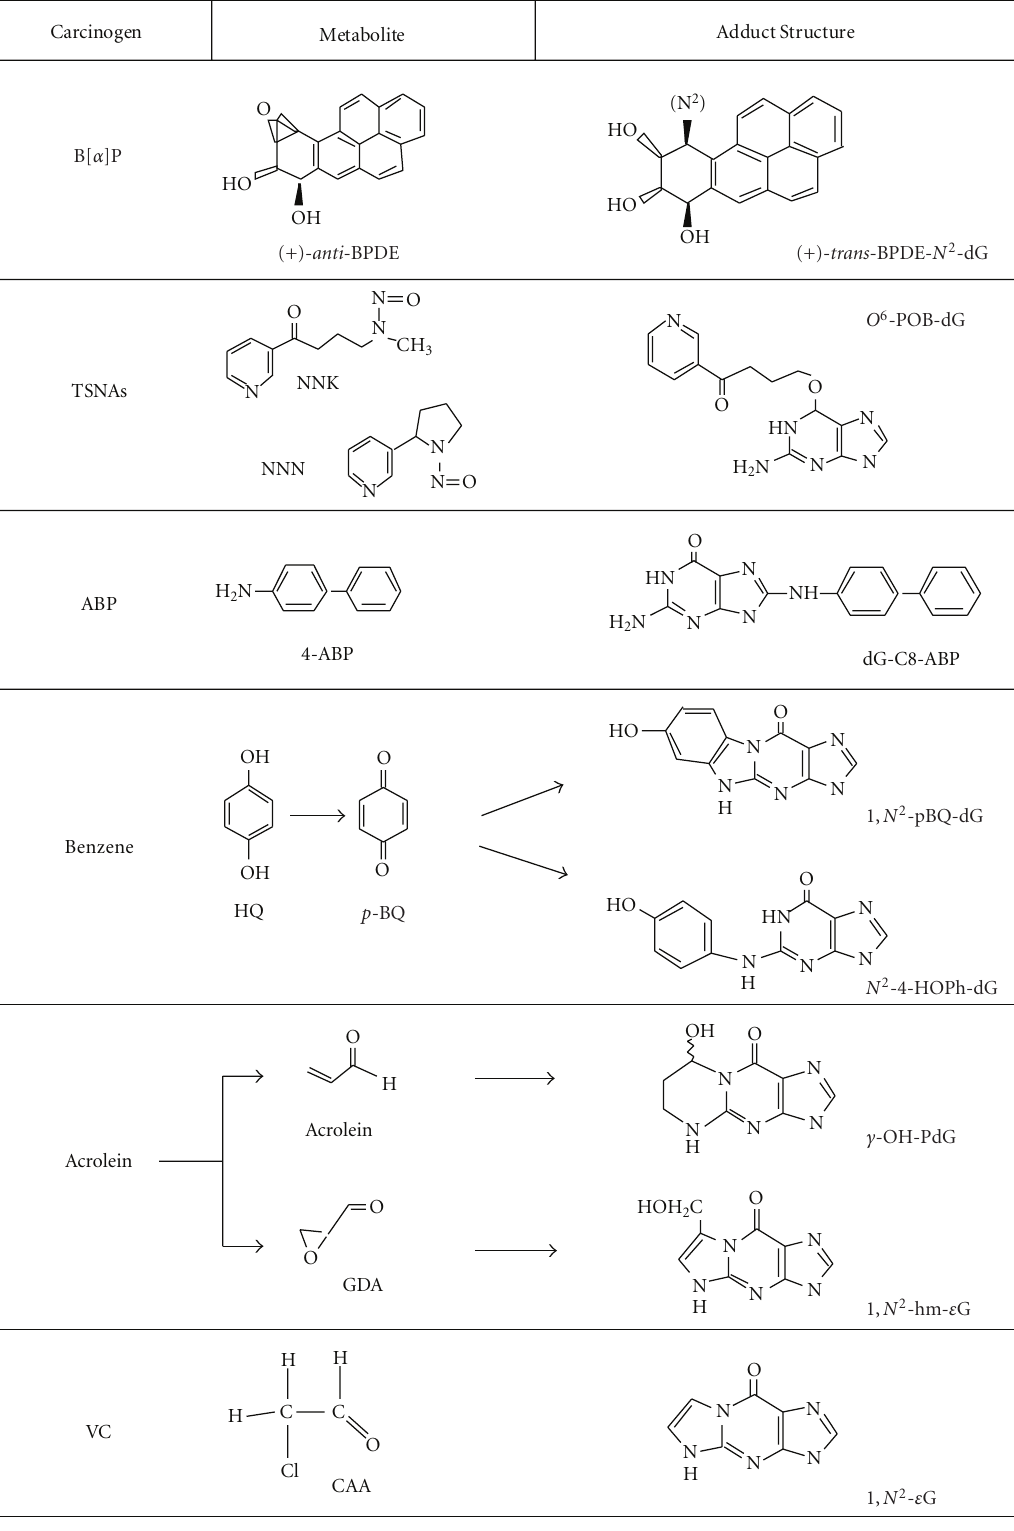
Figure 2: Structures of tobacco carcinogens, metabolites, and bulky dG adducts. These are only the partial list of DNA reactive carcinogens in cigarette smoke. The dG adducts listed are representatives of the adducts formed by the corresponding metabolites. Note that the stereochemistry of BPDE-DNA adducts is complex (see text). Acrolein can form two propano dG isomers, γ -HO-PdG (major), and α - HO-PdG (minor). CAA forms angular N 2 ,3- ε G, an isomer for 1, N 2 - ε